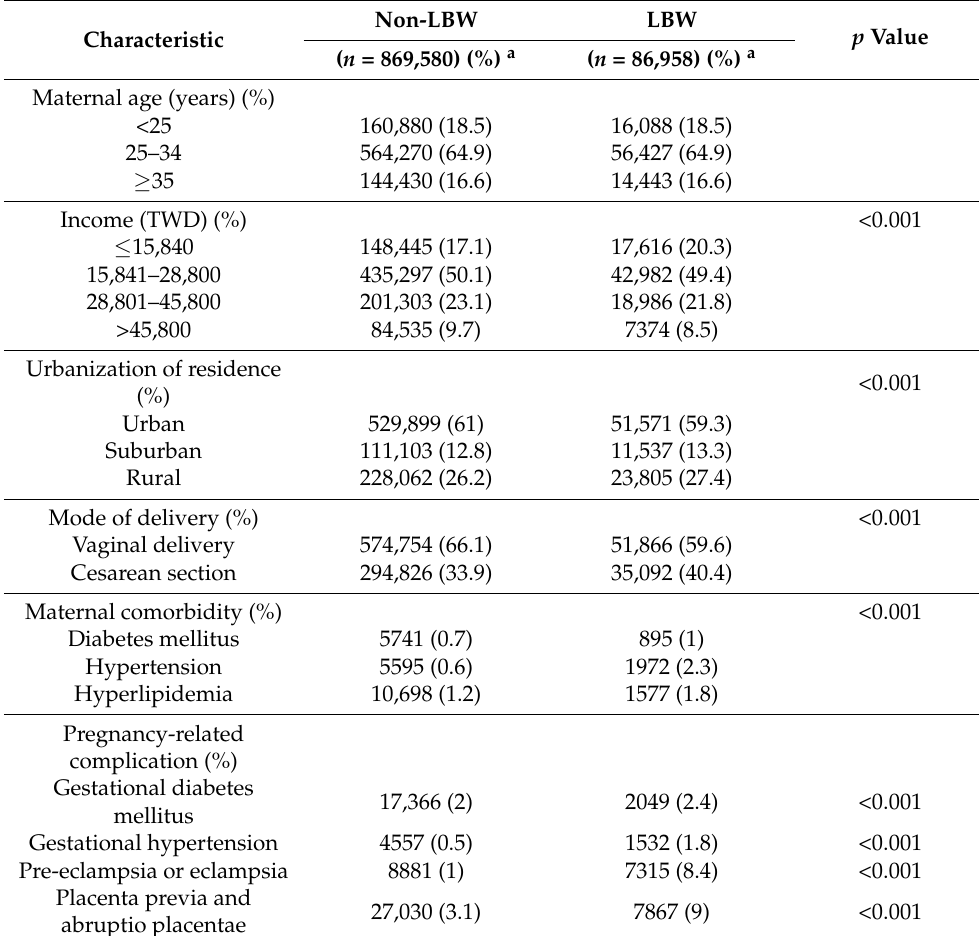
Table 1. Basic characteristics of the study